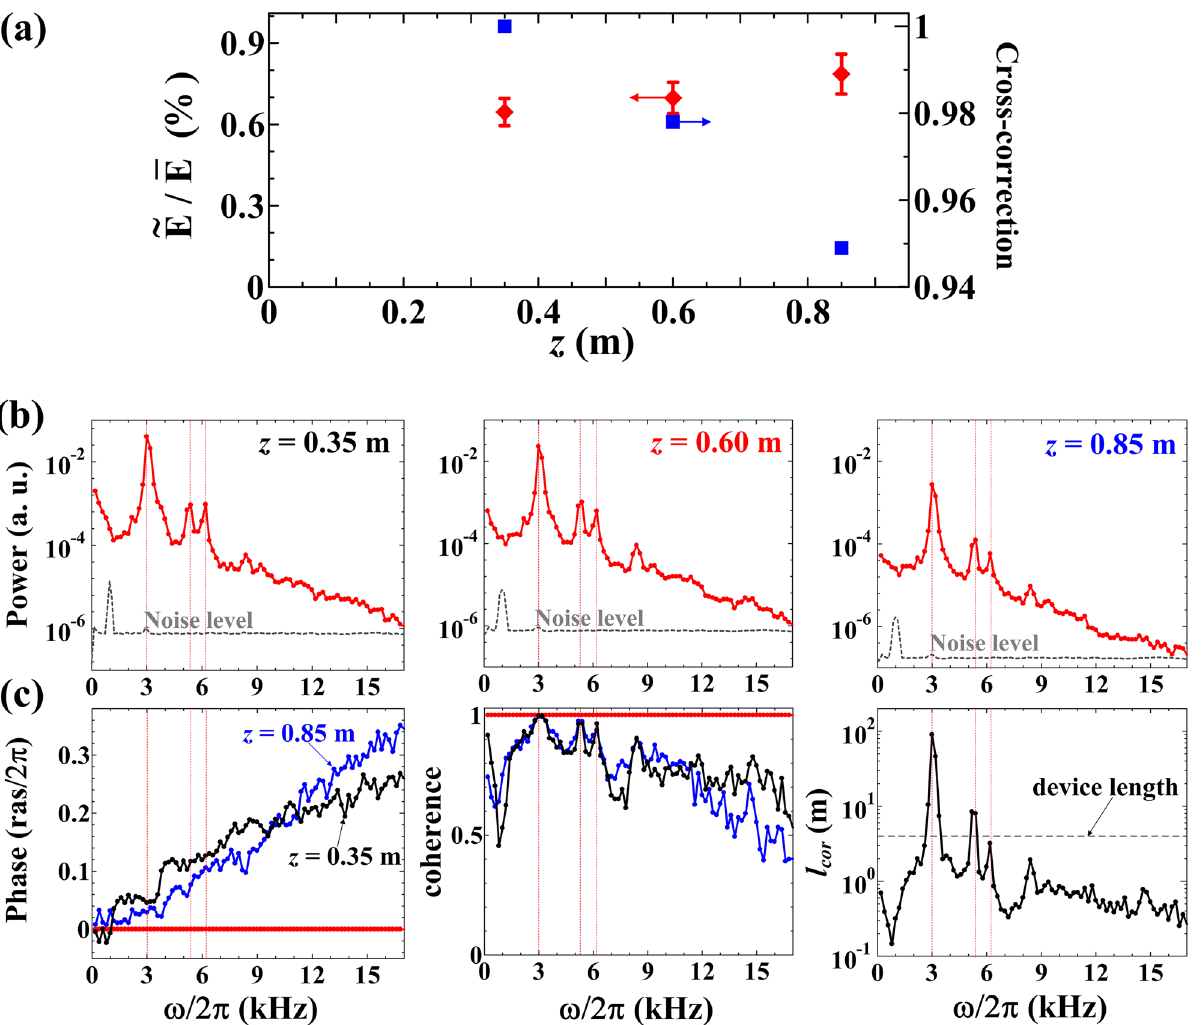
Figure 6. ( a ) Axial dependence of the normalized amplitude of total emission fluctuations ( f ≤ 20 kHz) and the cross-correction. ( b ) Fluctuation spectra of the total plasma emission at the axial positions of z = 0.35, 0.60, and 0.85 m. ( c ) Axial cross-phase, coherence, and the correlation length ( l cor ) with reference position at z = 0.60 m. The calculations are performed in the quasi-steady state ( t = 0.32–0.50